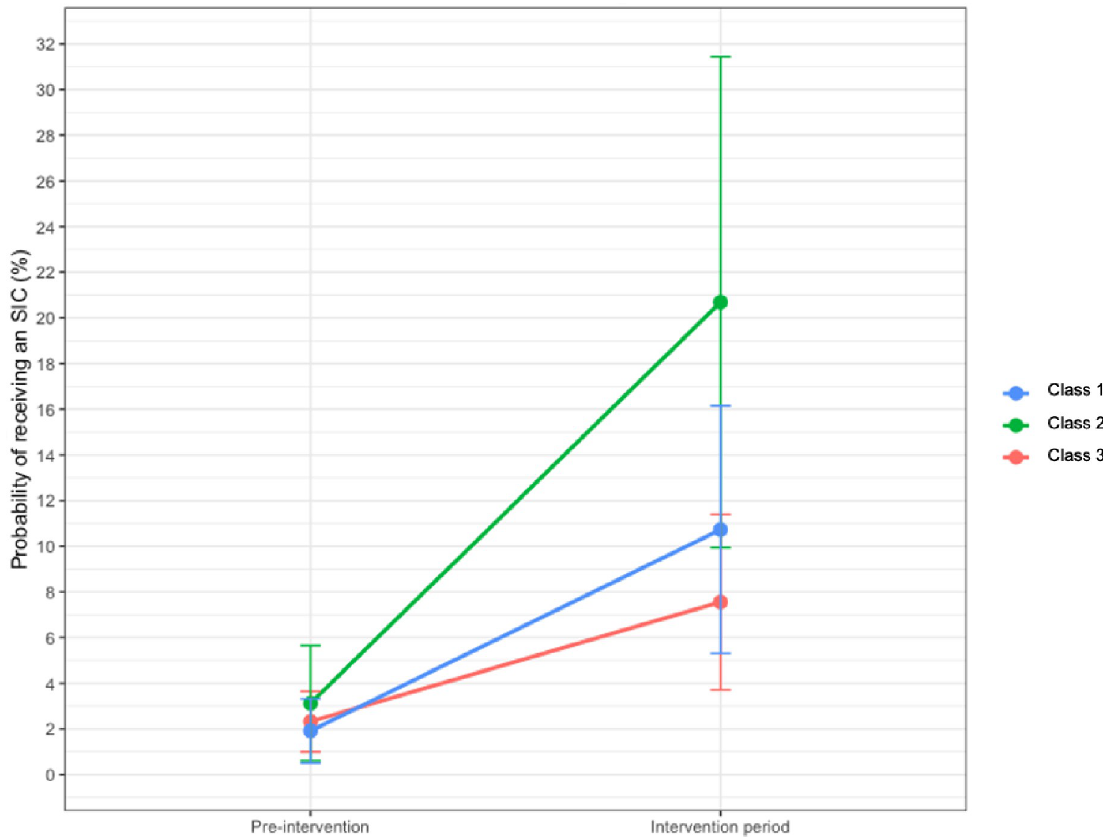
Fig 2. Intervention response by oncologist phenotype for patients with high predicted risk of mortality. The adjusted probability of a high risk patient (predicted 180-day mortality risk > 10%) of receiving an SIC during the pre-intervention and intervention periods by oncologist phenotype. Class 2 oncologists (green) had the highest response to the intervention, with the probability of receiving an ACP increasing from 3.1% during the pre-intervention period to 20.7% during the intervention period. The adjusted probability of ACP increased from 1.9% to 10.7% among class 1 oncologists (blue), and from 2.3% to 7.6% for class 3 oncologists